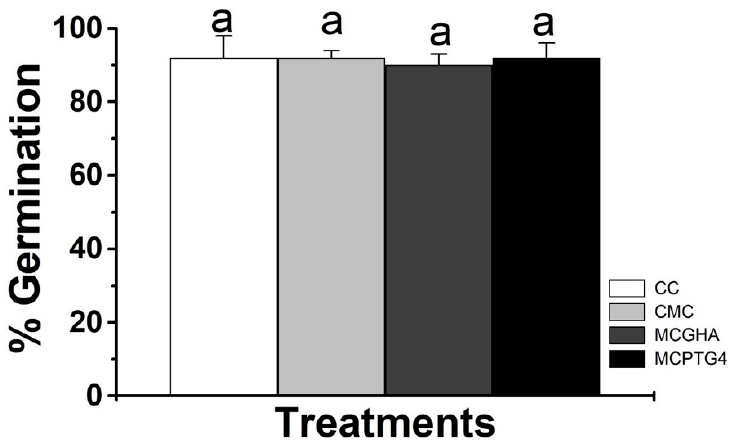
Figure 1. Zea mays plants germination percentage after 10 days of sowing with the different treatments. CC: Negative control, CMC: Negative control with only methylcellulose, MCPTG4: B. bassiana fungal strain PTG4 with methylcellulose, MCGHA: B. bassiana strain GHA with methylcellulose. Analysis done with Duncan’s Post hoc multiple range test ( α = 0.05) after one-way ANOVA. Graphical bars with the same letters indicate that there were no sig- nificant differences among them.